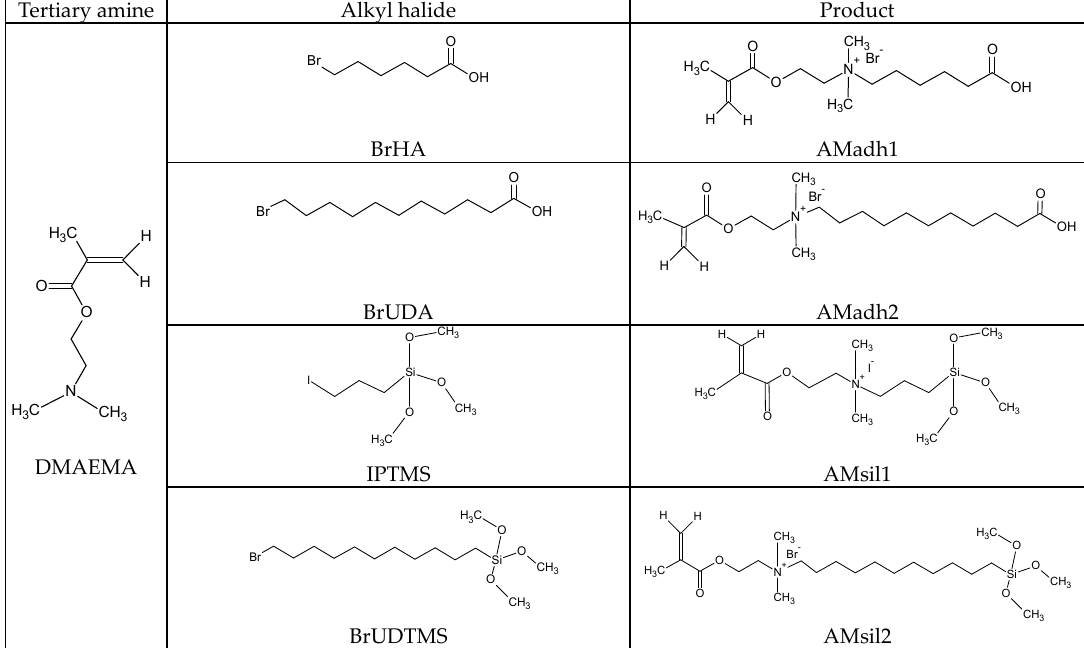
Figure 3. Typical DSC thermograms of the glass phase transitions of the first heating ramp (10 °C/min) for ( a ) AMadh1,( b ) AMadh2, ( c ) AMsil1 and first cool/second heat curves of ( d ) AMsil2.